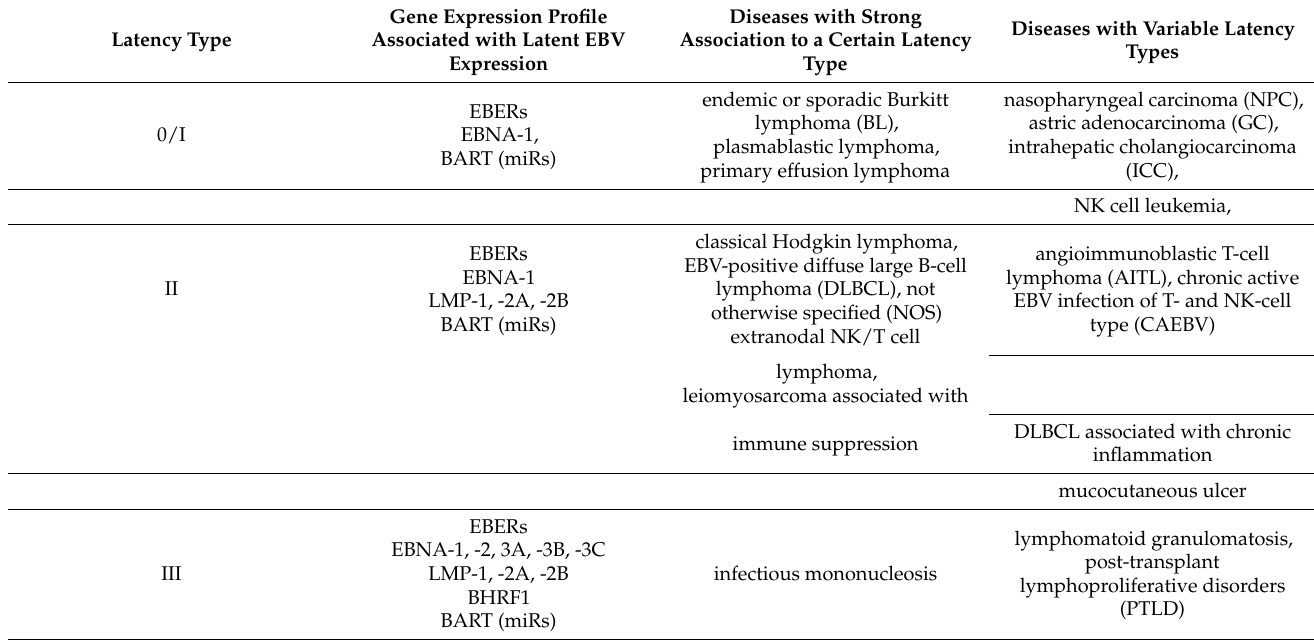
Table 2. EBV-associated gene and protein expression profiles, allocated latency type and related diseases. Latency